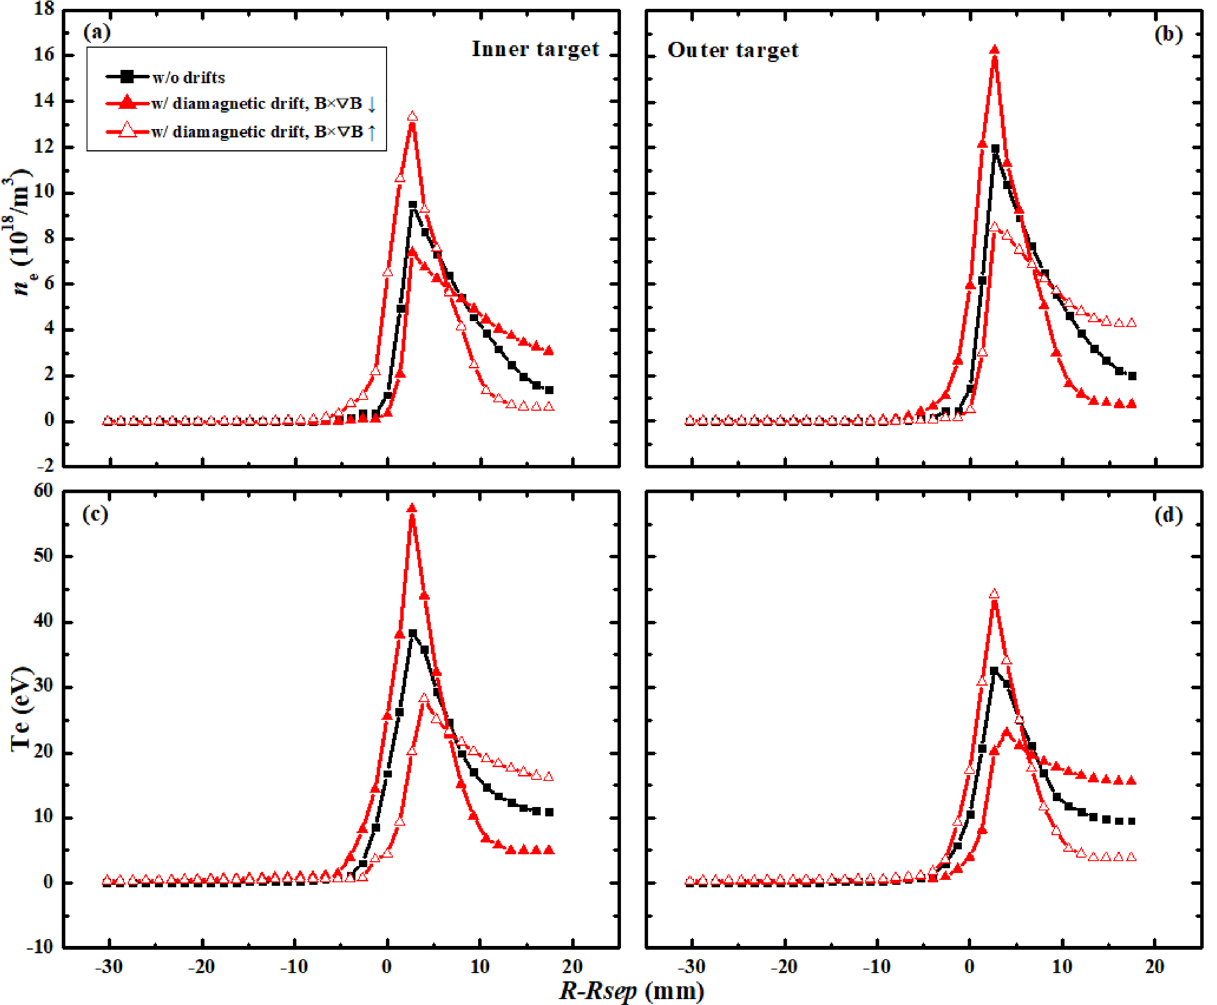
Figure 4. The divertor plasma densities and temperature at the inner and outer targets for case without drifts and cases with only diamagnetic